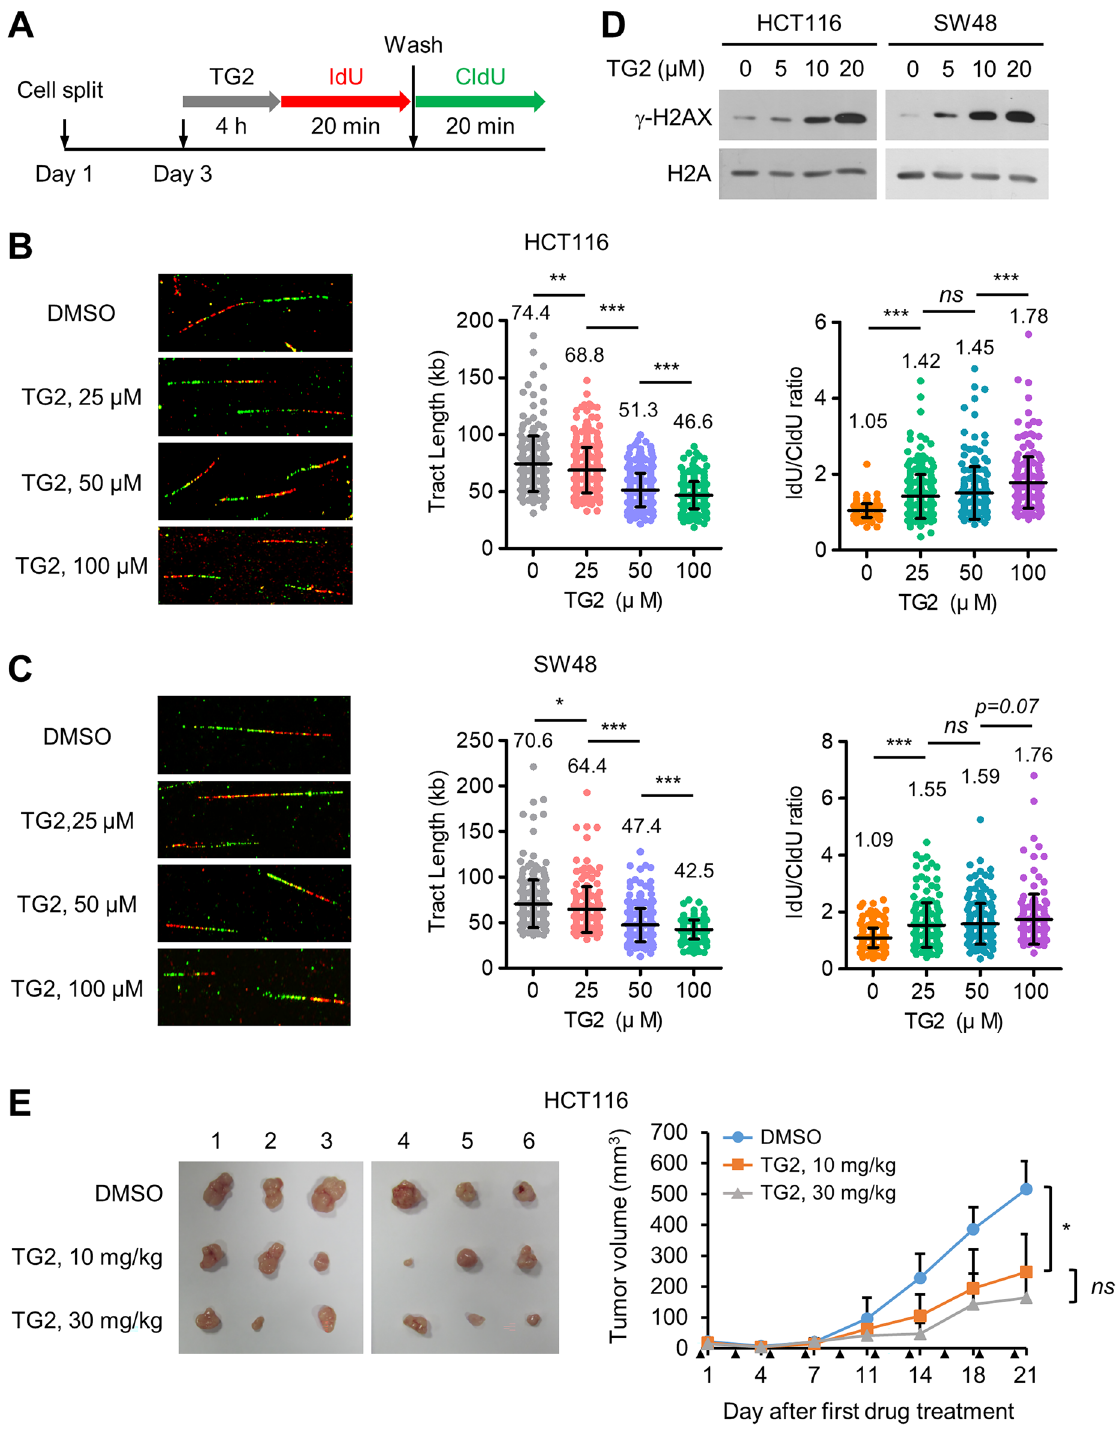
Figure 8. TG2-179-1 induces replication defects in colon cancer cells and inhibits colon tumor growth. ( A ) Experimental scheme. ( B , C ) HCT116 ( B ) and SW48 cells ( C ) were treated with increasing concentrations of TG2-179-1 for 6 h and were then subjected to a DNA fiber assay. (Left) Representative images of DNA fibers. (Middle) Summary of the IdU and CldU track lengths. Fiber counts for the scatter plot (in the same order as presented in the graph): 210, 304, 321, and 285 for HCT116; 251, 166, 285, and 201 for SW48. (Right) Summary of the IdU/CldU ratio. Fiber counts for the scatter plot (in the same order as presented in the graph): 162, 243, 181, and 213 for HCT116; 229, 174, 188, and 151 for SW48. ( D ) After cells were treated with increasing concentrations of TG2-179-1 for 48 h, histone extracts were prepared for immunoblotting. Representative data from three similar results are shown. ( E ) Results of the xenograft experiment showing that TG2-179-1 inhibits the tumorigenic growth of HCT116 cells. (Left) Images of tumors excised from mice. (Right) Summary graph. The arrowhead indicates the time point for drug injection. n = 6; error bars, mean ± s.d.